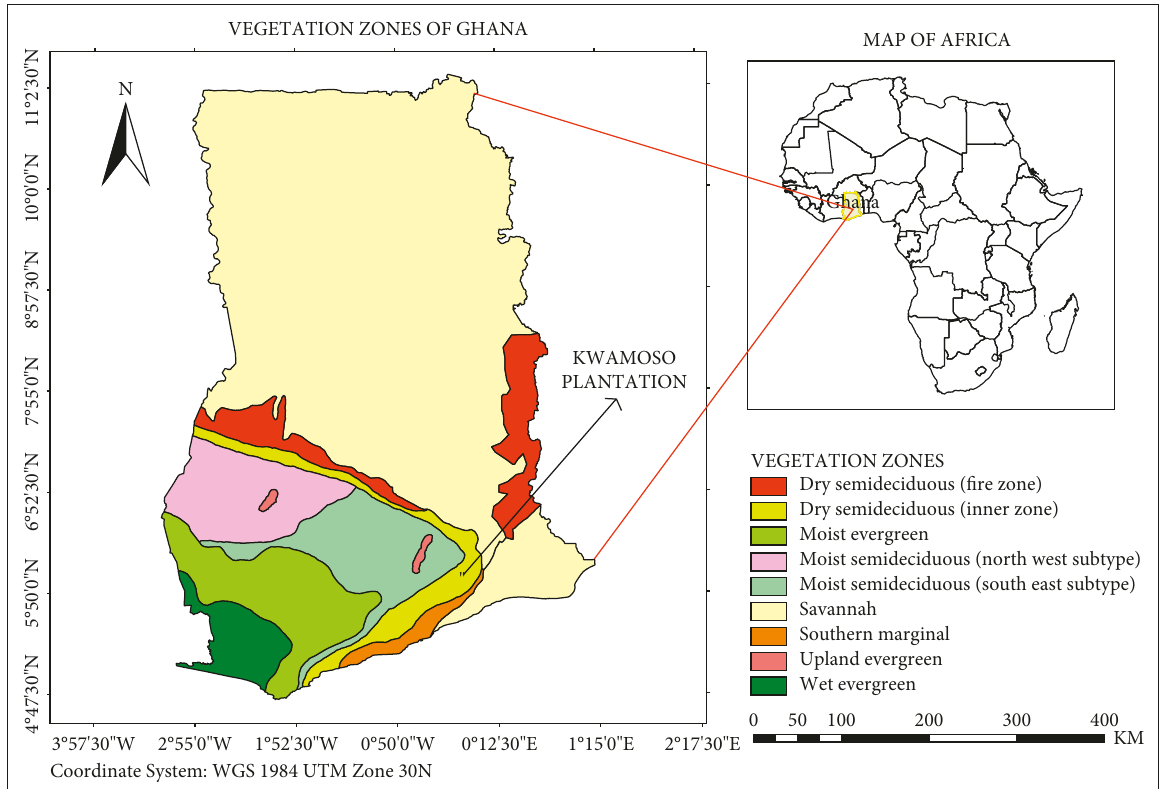
Figure 1: Map of Ghana showing the study site adapted from